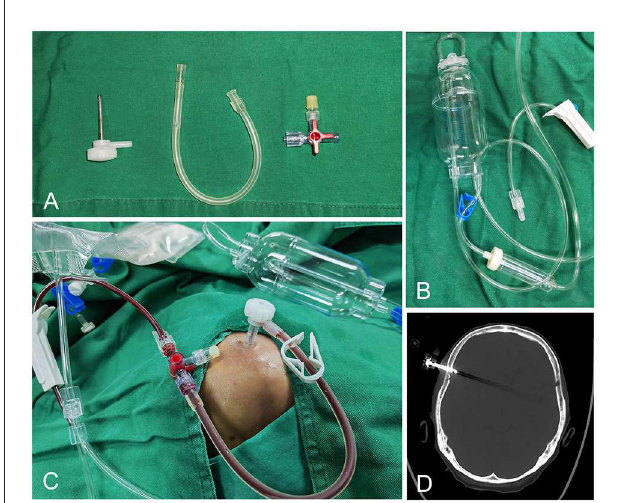
FIGURE1 The components of SEPS: Stainless steel evacuating port, silicone tubing, three-way stopcock, and hermetical drainage system (A, B) . The evacuating port is connected to the silicone tubing, a three-way stopcock, and a closed drainage system (C) . Postoperative CT bone window demonstrates the port in position (D)